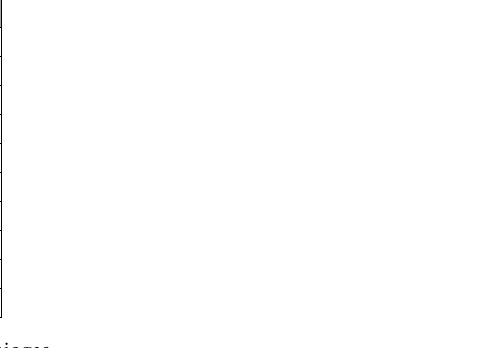
Parameter Before pretreatment After pretreatment